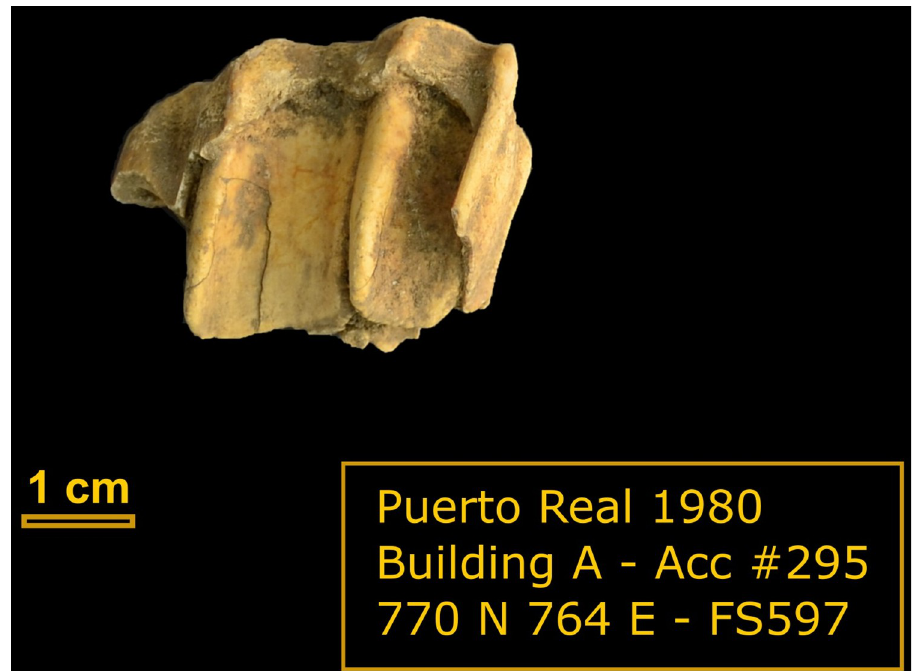
Fig 2. Picture of the horse specimen R0121-03 (FM-EAP Catalog Number 02951527).